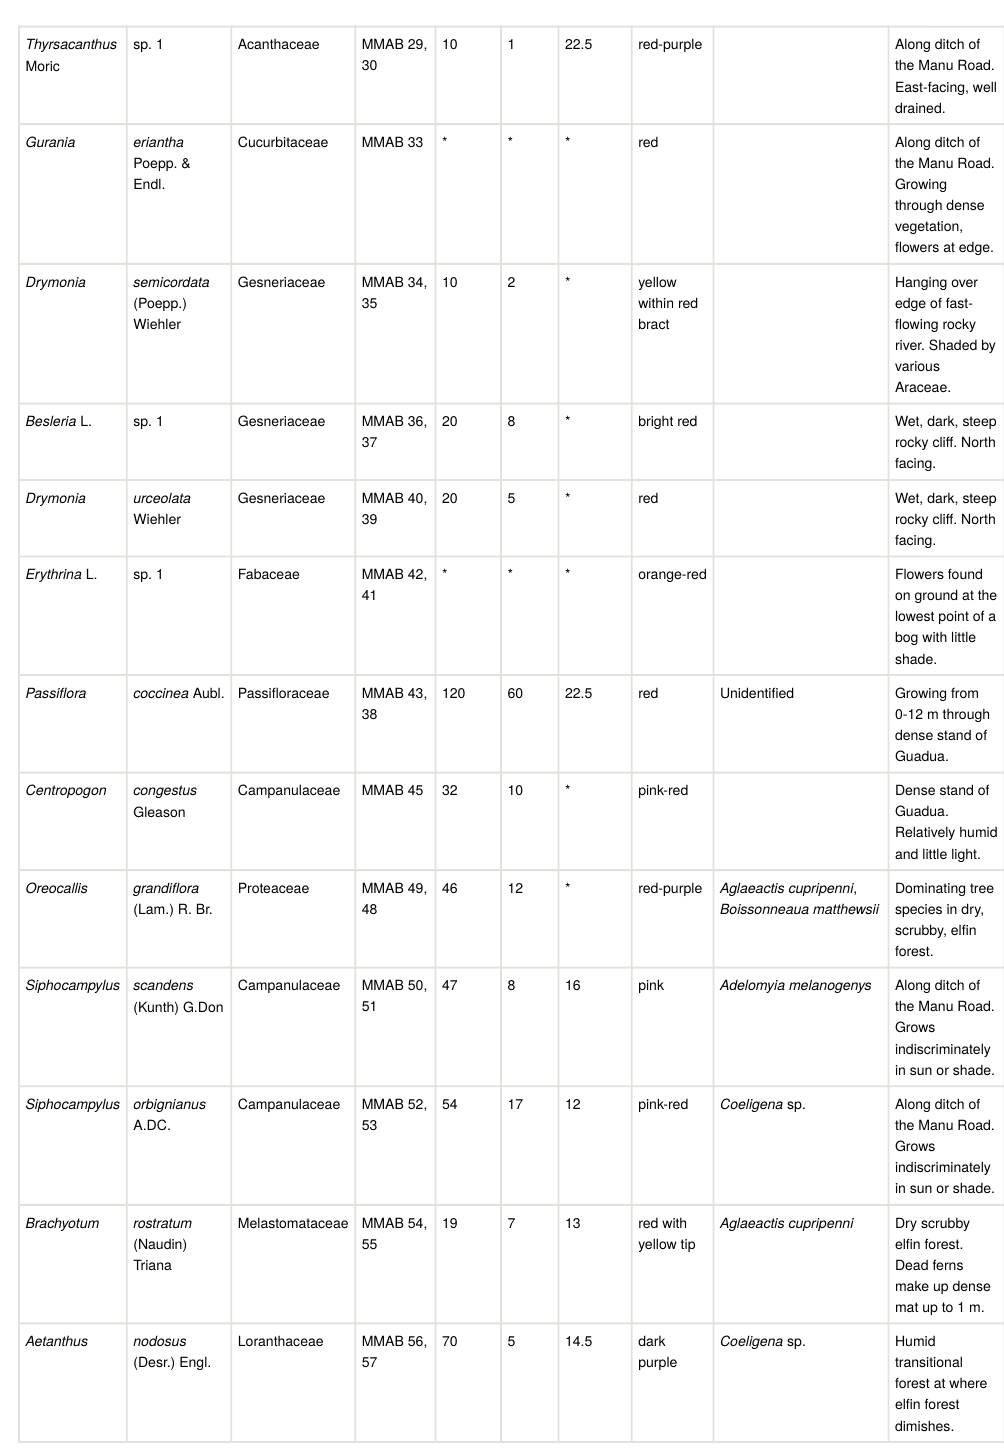
yellow within red bract bright red Wet, dark, steep red Wet, dark, steep orange-red Flowers found 22.5 red Unidenti fi ed Growing from * pink-red Dense stand of * red-purple Aglaeactis cupripenni , Boissonneaua matthewsii 16 pink Adelomyia melanogenys Along ditch of 12 pink-red Coeligena sp. Along ditch of dark Coeligena sp. Humid purple